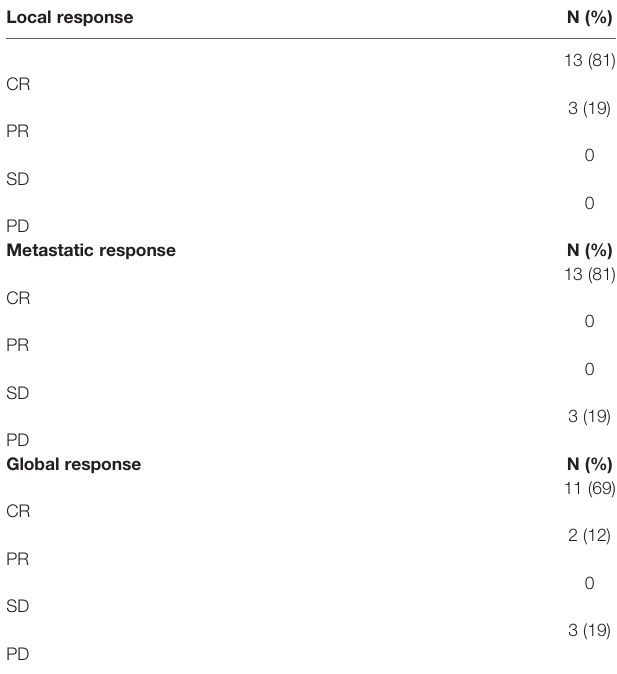
TABLE 5 | Response after